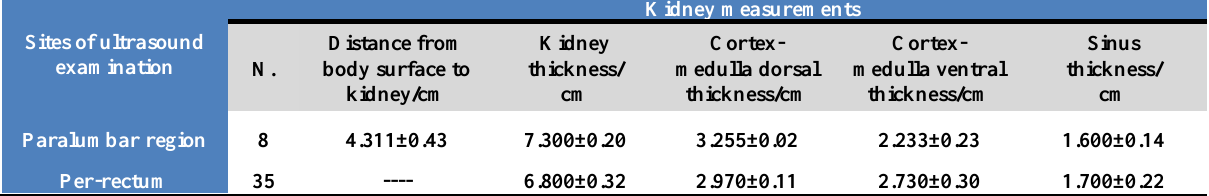
Table, 2: Left kidney Ultrasonographic measurements (Mean±SD) of normal adult buffalos. Sites of ultrasound